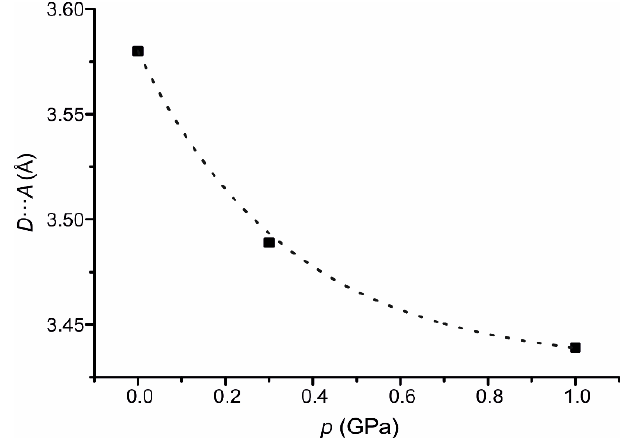
Figure 6. Changes in the donor···acceptor distance for the C − H··· π interactions for the pure reactant crystal along with the increase in pressure. The data for 0.1 MPa were taken from [5].